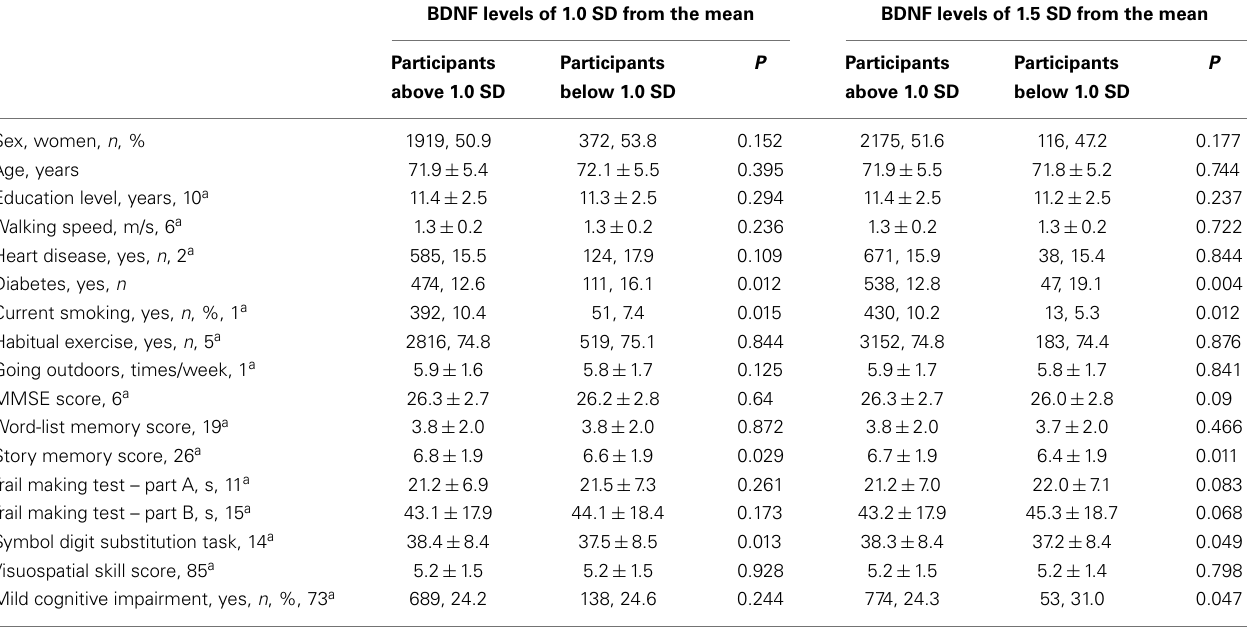
Table 2 | Comparisons between BDNF levels of 1.0 and 1.5 SD from the mean